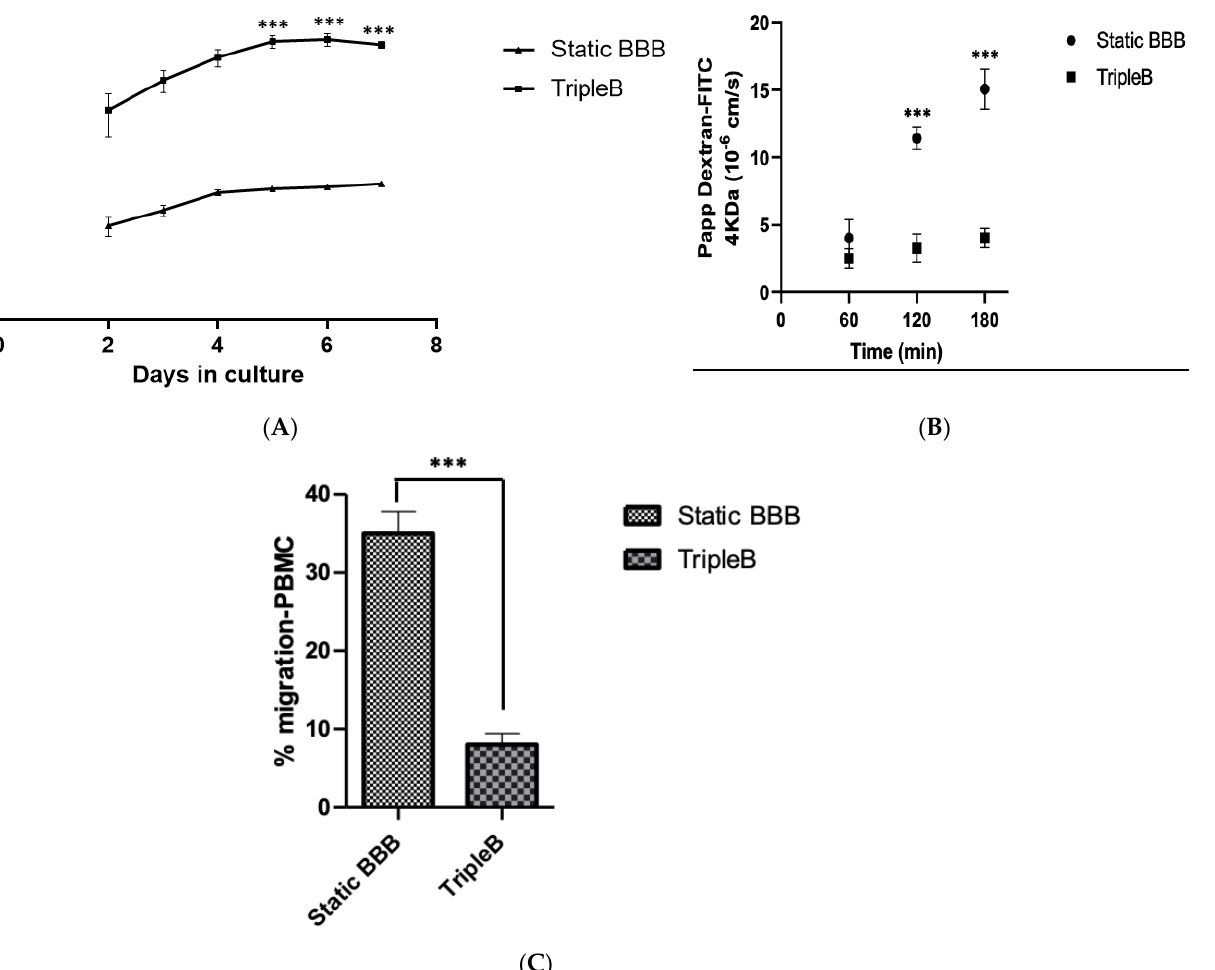
13 of 24 PBMCs towards a chemokine gradient across a well-formed dynamic in vitro BBB as com- pared to a static BBB model. Migration assays were performed between days 5 and 6 of culture, when the co-cultures established functional barrier properties. PBMCs were